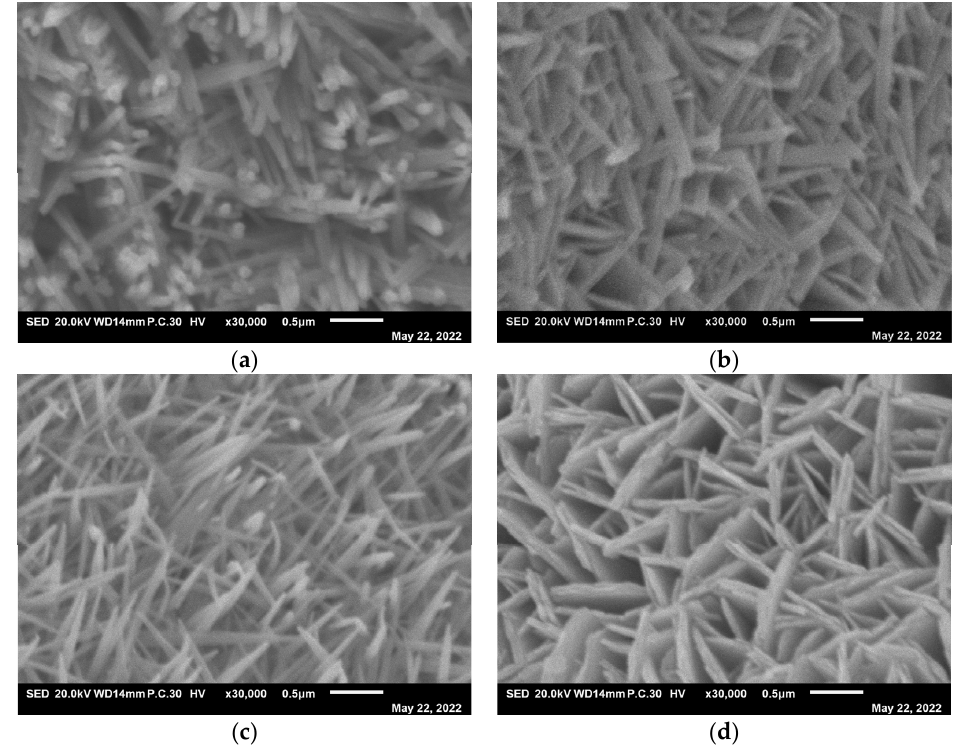
Figure 3. High magnification of ( a ) NiCo-LDH/NF, ( b ) Ni 4 Co 4 Fe-LDH/NF, ( c ) Ni 4 Co 4 Fe 2 -LDH/NF, and ( d ) Ni 4 Co 4 Fe 3 -LDH/NF nanostructures.